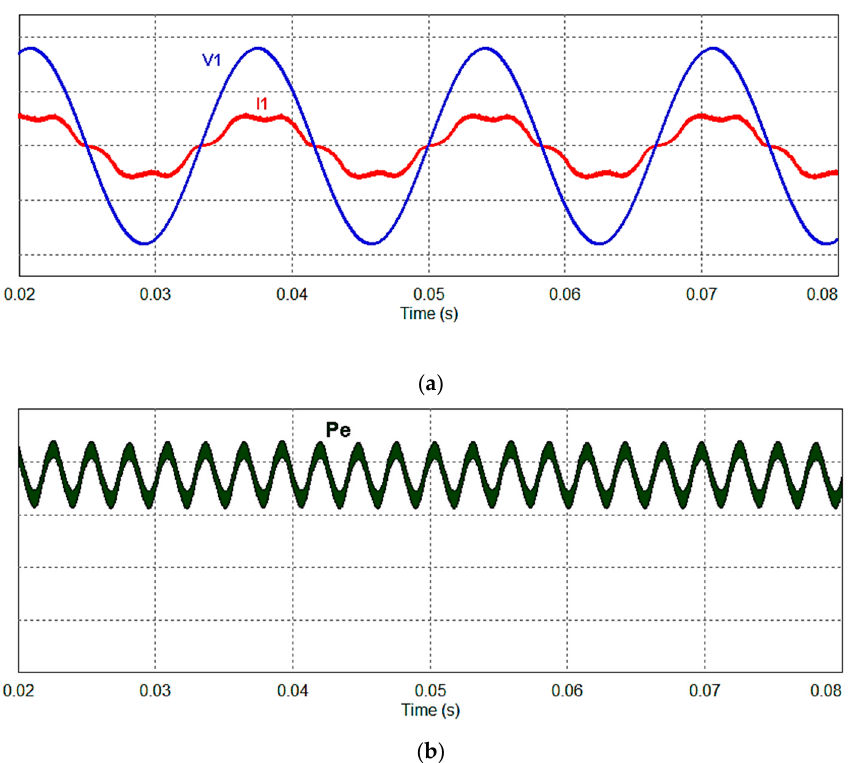
Figure 2. Single-switch three-phase discontinuous conduction mode (DCM) boost converter: ( a ) typical input voltage and filtered current; ( b ) electric power absorbed from the source.